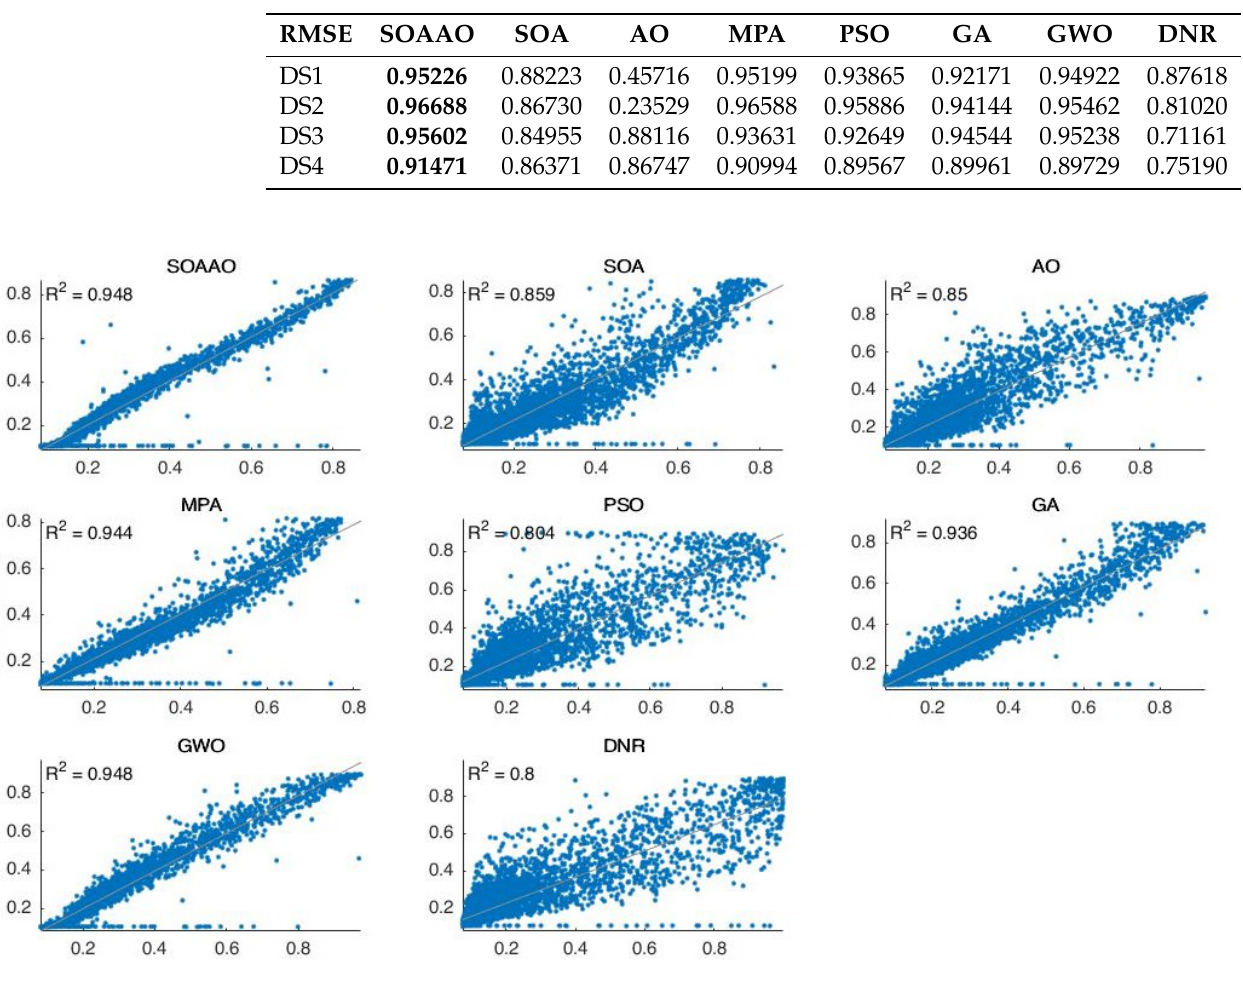
Figure 2. Results on